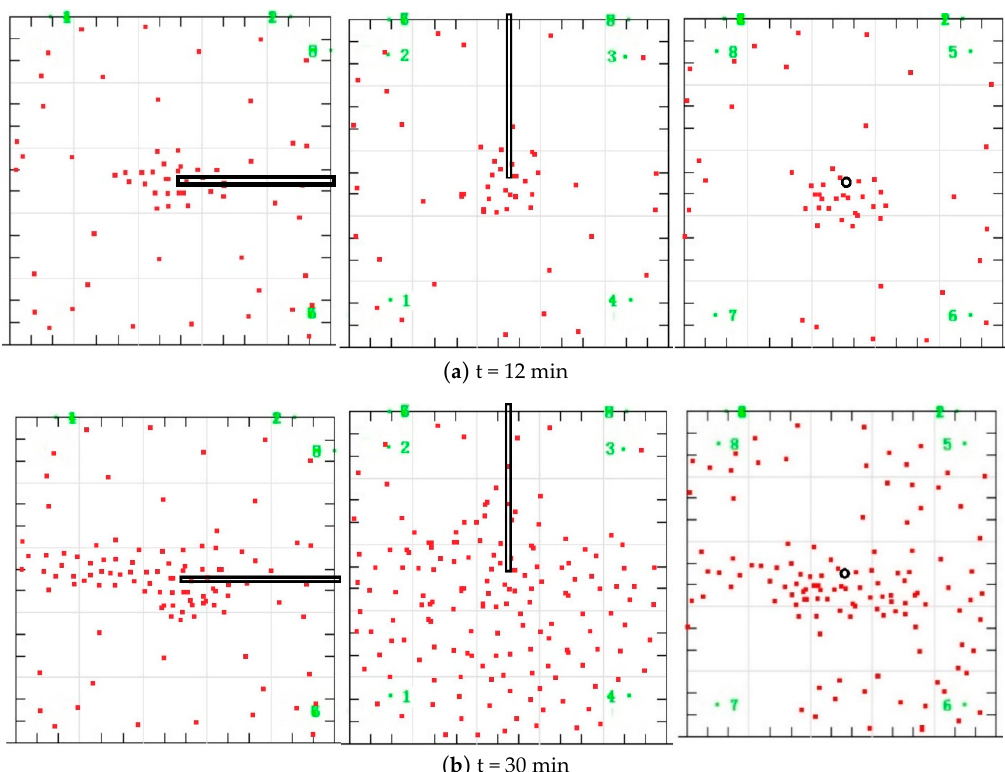
Figure 12. AE results of the fracturing of H2 at t = 12 min ( a ) and t = 30 min ( b ).